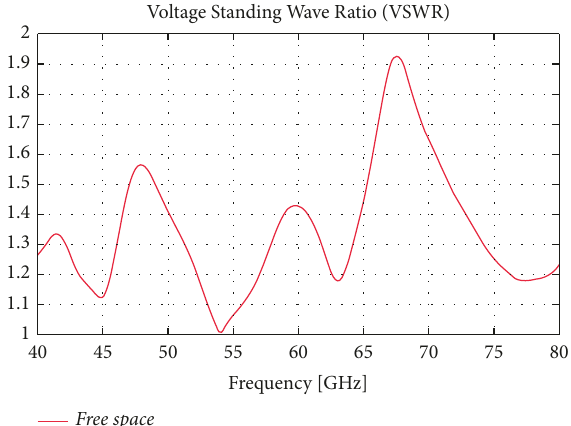
Figure 26: VSWR curve of the 2 × 2 antenna array.